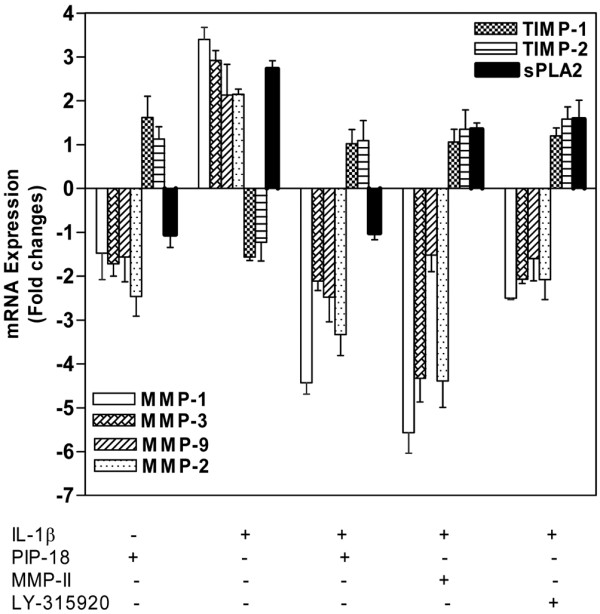
Peptide treatment inhibited MMP and sPLA2 gene expression in IL-1β induced RA SF. Cells were pretreated with the peptide (phospholipase inhibitor from python (PIP)-18), secretory phospholipase A2 (sPLA2) inhibitor (LY315920) or matrix metalloproteinase inhibitor (MMP-II) at 5 μM for one hour, and incubated with hrIL-1β (10 ng/ml) for 24 hours before isolating total RNA. Relative mRNA expression levels were determined by real-time PCR analyses, normalized to internal GAPD values, and plotted relative to control samples treated with vehicle (0.5% dimethyl sulfoxide). Gene-specific real-time analysis was performed for all seven mRNA targets, sPLA2, MMP-1, -2, -3, -9, tissue inhibitor of metalloproteinase (TIMP)-1 and TIMP-2. Results shown are the mean ± standard deviation of fold inductions from three independent experiments with a pool of rheumatoid arthritis (RA) synovial fibroblast (SF) cultures obtained from five RA patients.